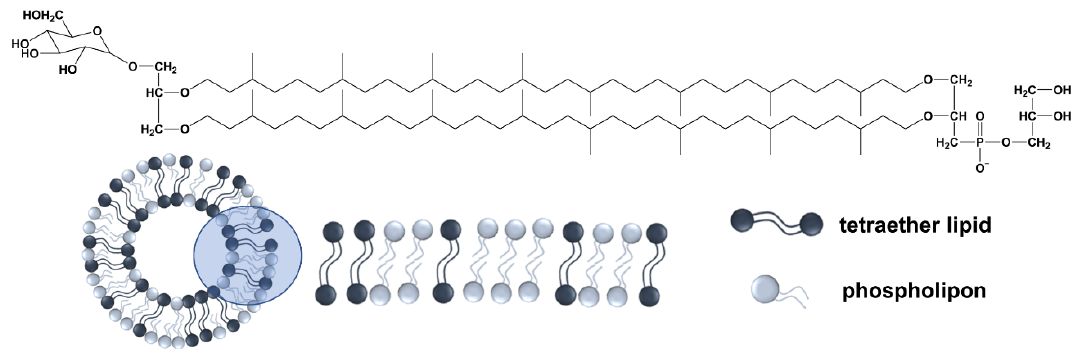
Figure 1. An illustration of the main structure of the isolated tetraether lipids and the membrane organization of the phospholipids (Phospholipon) and the TEL within the liposomes.